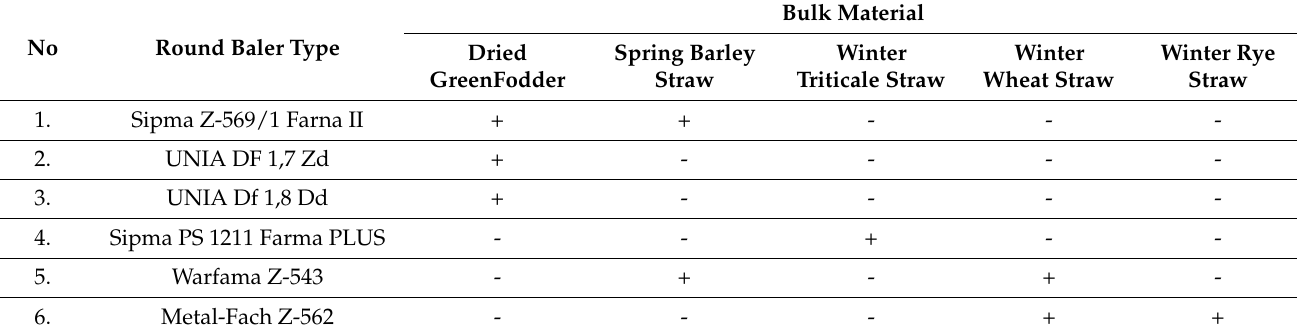
Table 1. Variants harvest of bulk materials during tests of the COVERNET mesh produced in the Tama LT